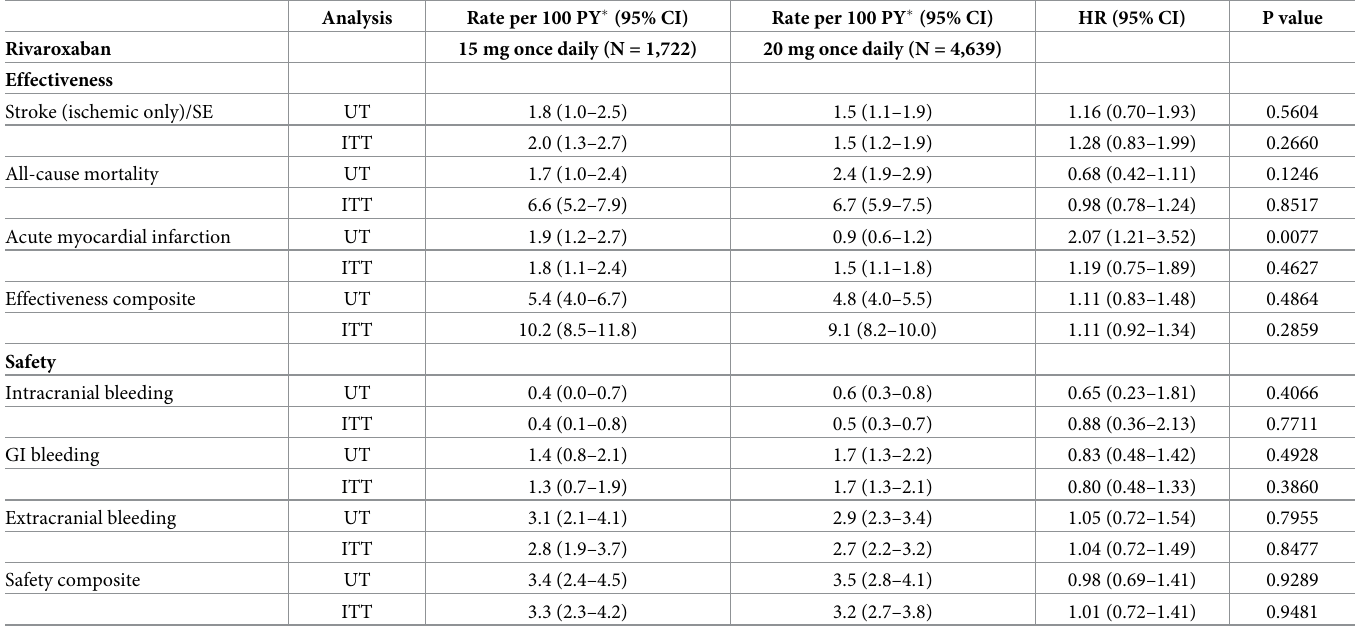
Table 2. Comparative effectiveness and safety of low-dose and standard-dose rivaroxaban after inverse probability of treatment